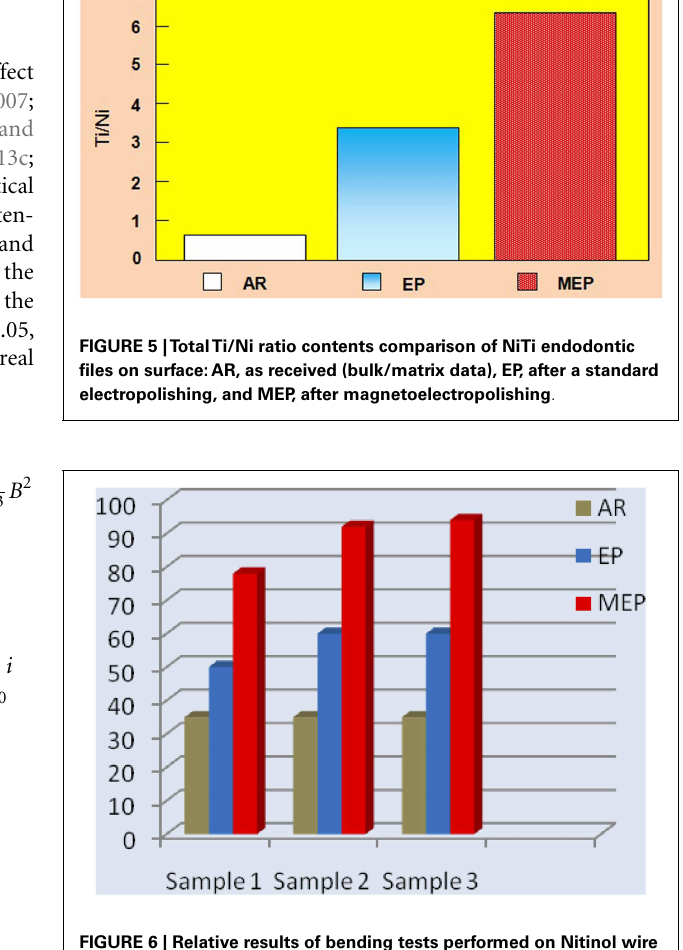
FIGURE 6 | Relative results of bending tests performed on Nitinol wire samples after EP and MEP;AR as received